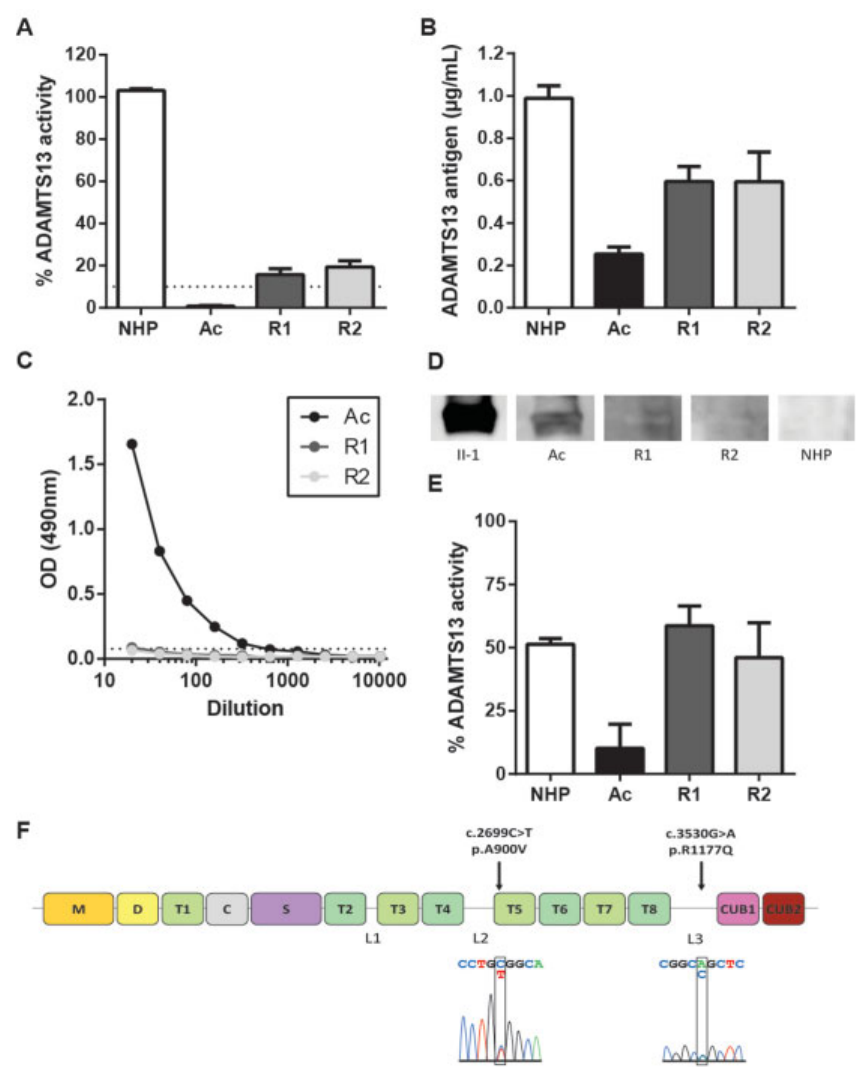
Fig. 1 ADAMTS13 activity, antigen, anti-ADAMTS13 autoantibodies and gene analysis from the TTP patient. Patient plasma samples of acute (Ac) and remission phases (one plasma sample just after the acute episode [remission 1, R1] and one plasma sample almost 2 years after achieving complete remission [remission 2, R2]) were analyzed. ( A ) ADAMTS13 activity was measured using the FRETS-VWF73 assay. NHP was used as a reference and set as 100% ADAMTS13 activity. Below 10% (dotted line) indicates severely decreased activity ( n ¼ 3). ( B ) Plasma ADAMTS13 antigen levels were measured using ELISA. NHP was used as a reference and set as 1 µg/mL ( n ¼ 3). ( C ) Anti-ADAMTS13 autoantibodies were detected by adding plasma to wells coated with rhADAMTS13. The dotted line indicates the background ( n ¼ 1). ( D ) Western blot was also used to detect anti-ADAMTS13 autoantibodies. rhADAMTS13 was loaded onto an SDS-polyacrylamide gel. After transfer, the membrane containing rhADAMTS13 was incubated with plasma samples, or puri fi ed human anti-ADAMTS13 antibody II-1 as a positive control. ( E ) A mixing experiment was performed to detect inhibitory anti-ADAMTS13 autoantibodies in plasma from the patient. Heat-inactivated patient plasma was added to fresh NHP (50 V%) and residual ADAMTS13 activity was determined using the FRETS-VWF73 assay ( n ¼ 3). ( F ) Representation of the domain structure of ADAMTS13 with the metalloprotease domain (M), disintegrin-like domain (D), a fi rst thrombospondin type 1 repeat (T1), cysteine-rich domain (C), spacer domain (S), seven additional T domains (T2-T8), and 2 CUB domains. The three fl exible linker regions are indicated by L1, L2, and L3. The SNP c.2699C > T (p.A900V) is located in the beginning of the T5 domain, while the mutation c.3530G > A (p.R1177Q) is located in the third linker region betweenT8 and CUB1 domains. The sequence chromatograms are shown below the ADAMTS13 domain structure and show the DNA sequence of the SNP and the mutation and their heterozygous